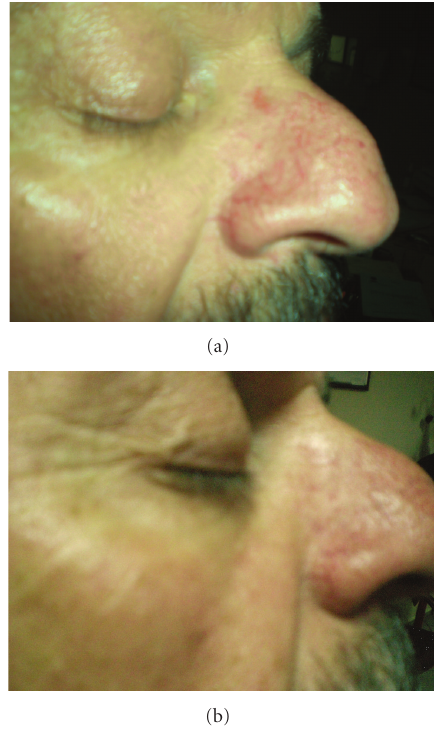
Figure 4: (a) leg telangiectasia of a patient before treatment, (b) leg telangiectasia in the patient after fifth session of the treatment, Category-III (partial